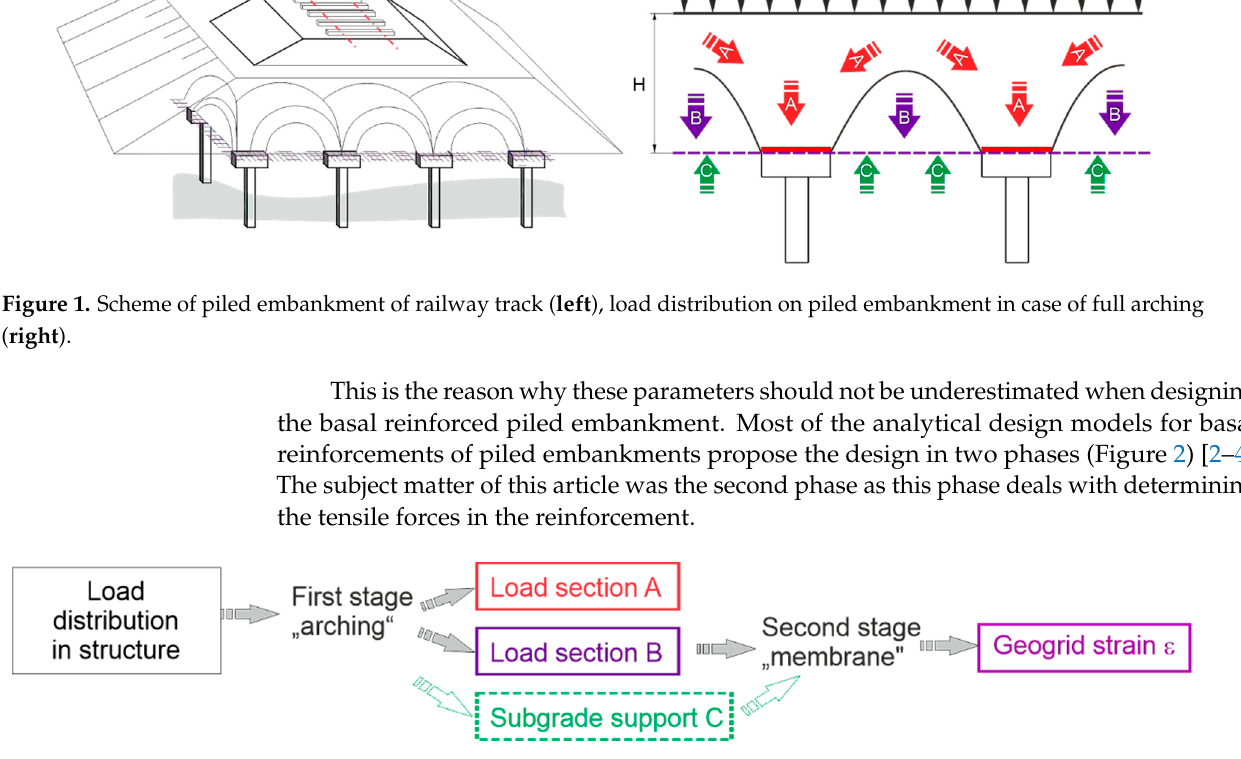
Figure 2. Distribution of the load in the piled embankment.